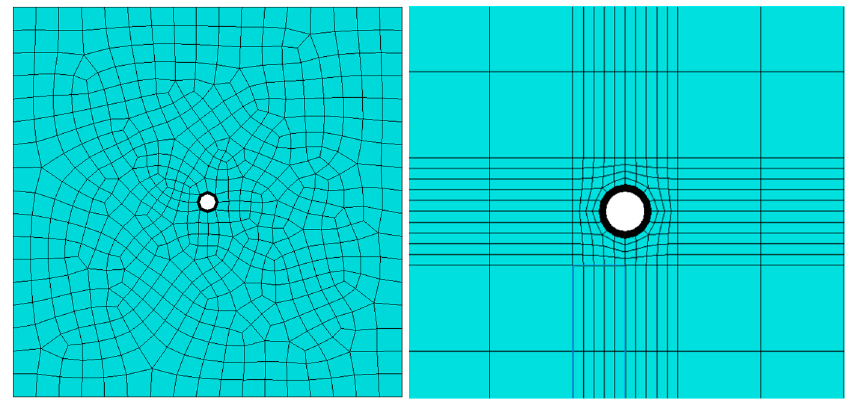
Figure 4. Without partitions ( left ); with partitions ( right ).